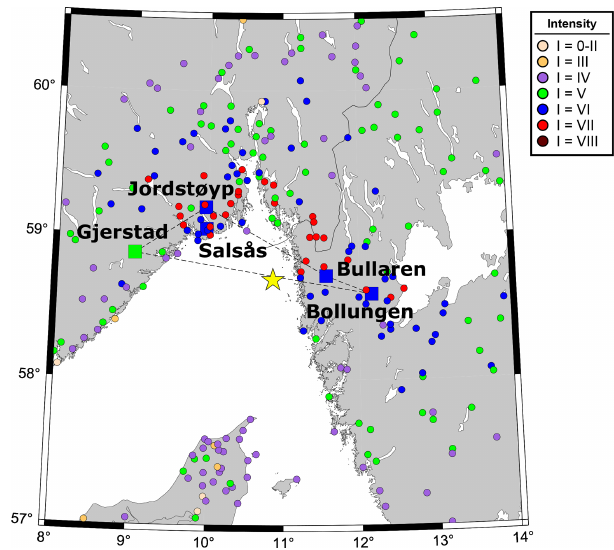
Figure 9. Data available for the 23 October 1904 M 5.4 earthquake. Blue squares are rockfalls triggered by the earthquake; the green square is a landslide in clayey soil. The yellow star shows the epi- centre location according to Bungum et al. (2009). Coloured dots are macroseismic intensity observations from Austegard (1975). The dotted polygon shows the landslide area determined from the observed